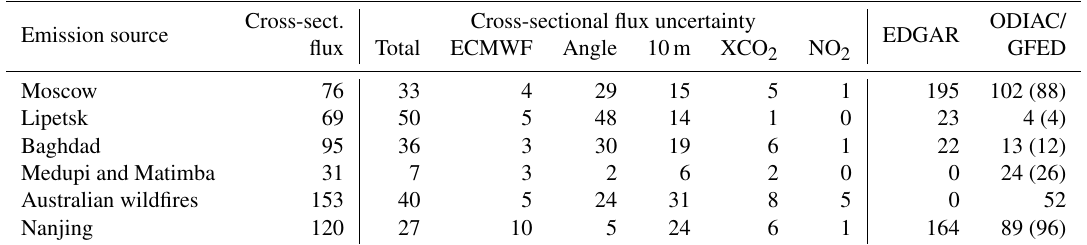
Table 1. Summary of cross-sectional flux results including uncertainty contributions (1 σ ) and comparison with emission databases EDGAR and ODIAC or GFED in the case of the Australian wildfires. The ODIAC values in brackets represent ODIAC emissions of 2016 and the month of the overpass in the same grid boxes as summed up for 2012. Note that the cross-sectional flux results correspond to the instantaneous time of the overpasses, while EDGAR and ODIAC emissions are annual or monthly averages; GFED emissions correspond to 6h averages (see Sect. 2.4). The uncertainty estimate is comprised of the total uncertainty and the uncertainties introduced by the ECMWF wind uncertainty, the uncertainty of the wind direction (10 ◦ ), use of the 10m wind (20%), the XCO 2 precision as reported in the data product, and the NO 2 precision as reported in the data product. All values are in units of MtCO 2 a − 1 . Cross-sect. Cross-sectional flux uncertainty Emission source